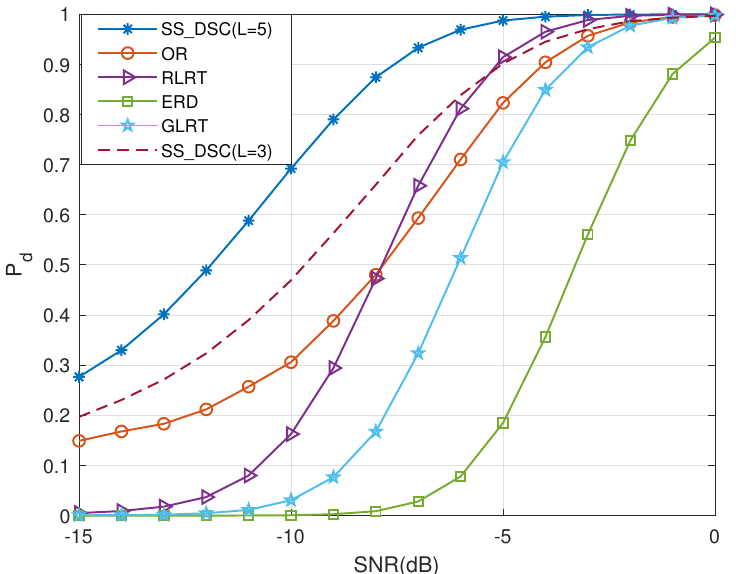
Figure 8. The probability of detection P d versus SNR for different algorithms when Num = 40 and P f =